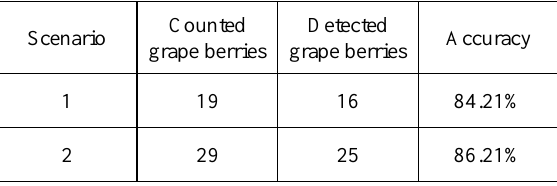
Table 1: Detection results for two different scenarios.